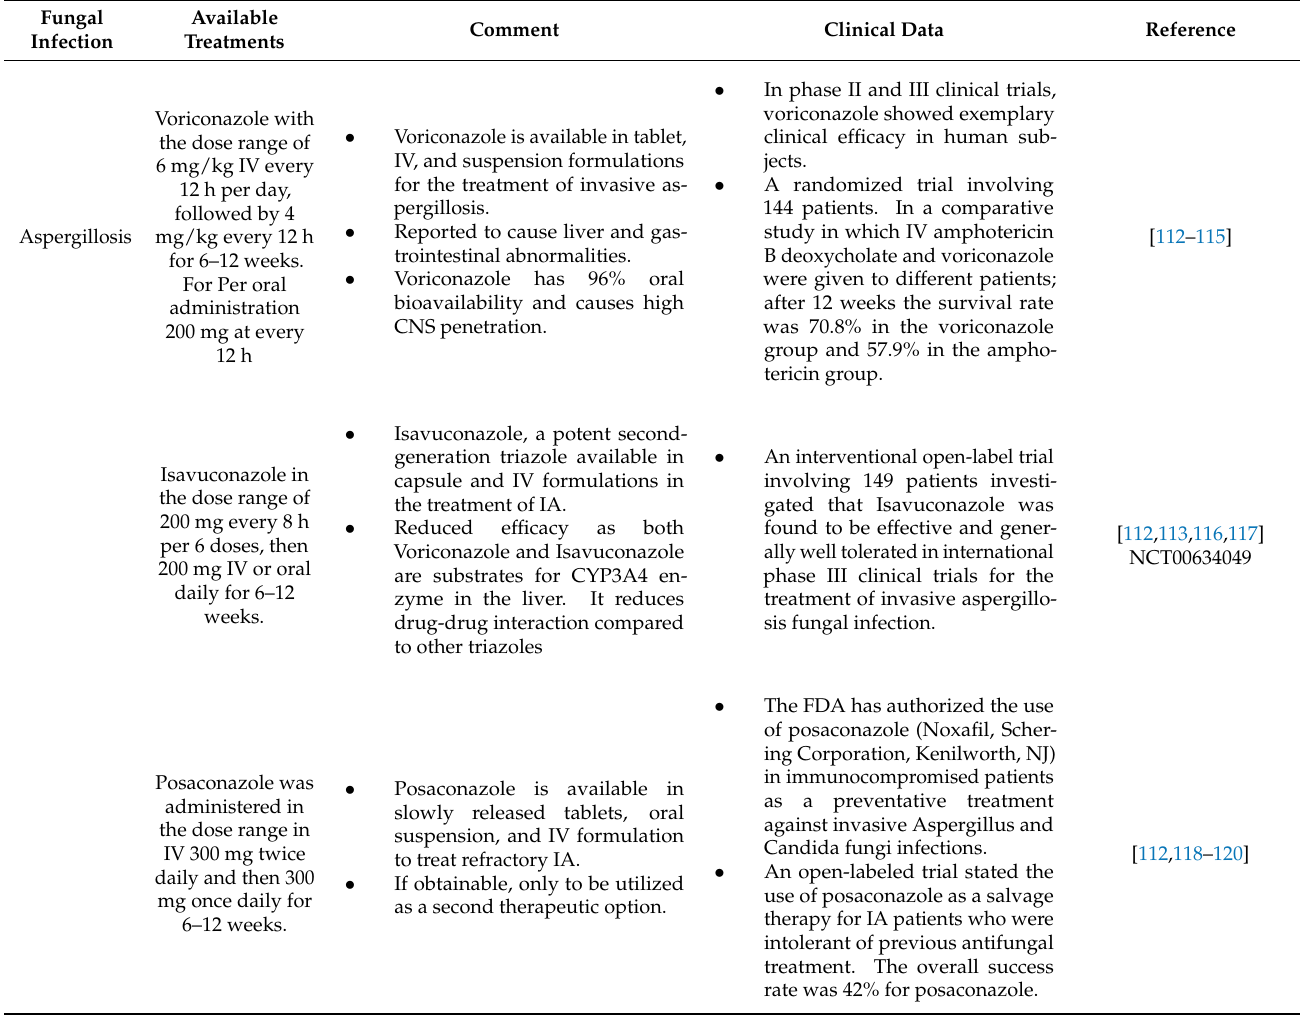
Table 3. Treatment measures for invasive fungal